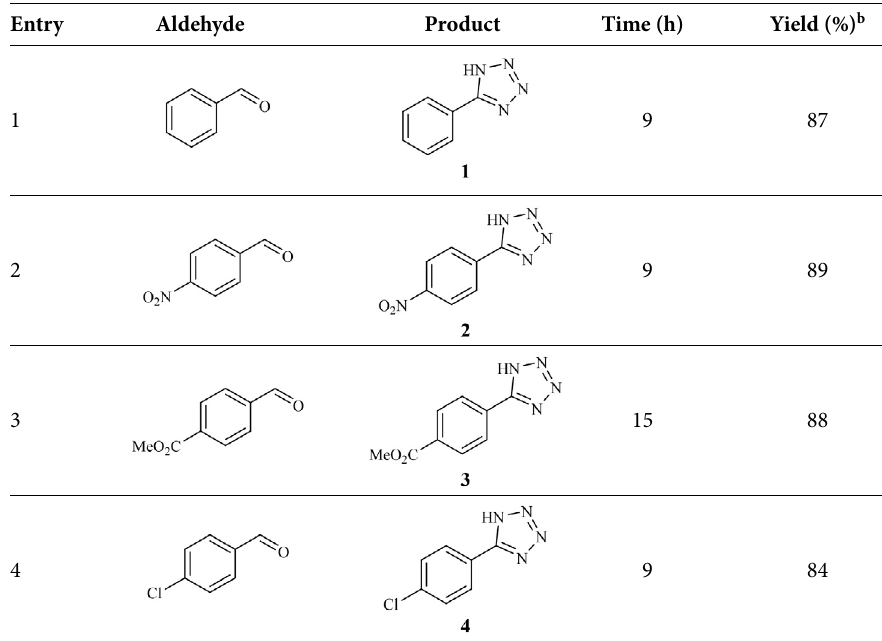
Table 2. Sequential one-pot synthesis of 5-substituted 1 H -tetrazoles from aldehydes via in-situ generation of nitriles followed by [2+3] cycloaddition with sodium azide using nano-Cu/C as a catalyst.